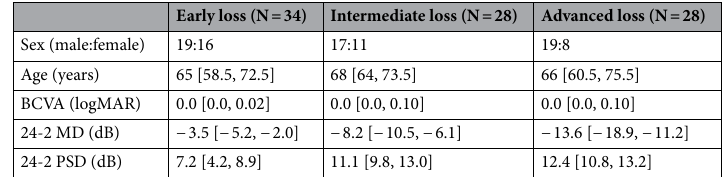
Table 1. Descriptive statistics of the test–retest sample. IQR interquartile range, MD mean deviation, PSD pattern standard deviation, BCVA best corrected visual acuity, IOP intra ocular pressure; Early glaucomatous